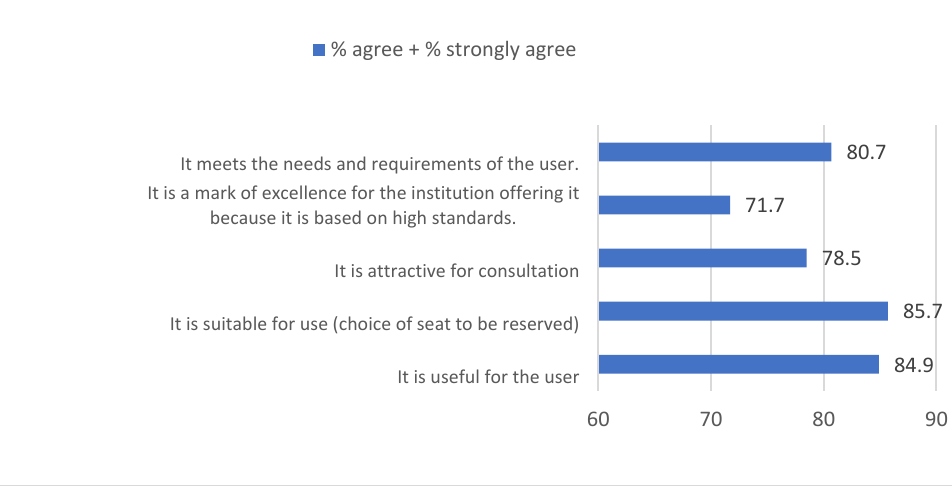
Figure 14. Assessment of the quality of the Biblio-Smart prototype.